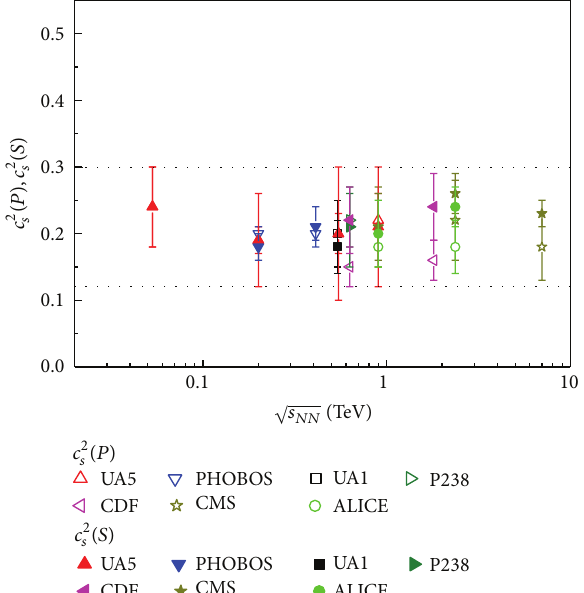
Figure 4: Correlations between 𝑐 2 𝑠 and √𝑠 𝑁𝑁 . The closed and open symbols represent, respectively, the values of 𝑐 2 𝑠 (𝑃) and 𝑐 2 𝑠 (𝑆) obtained in Figures 1–3 and listed in Table 1. The two lines described by 𝑐 2 𝑠 = 0.12 and 𝑐 2 𝑠 = 0.30 show a range for different 𝑐 2 𝑠 .